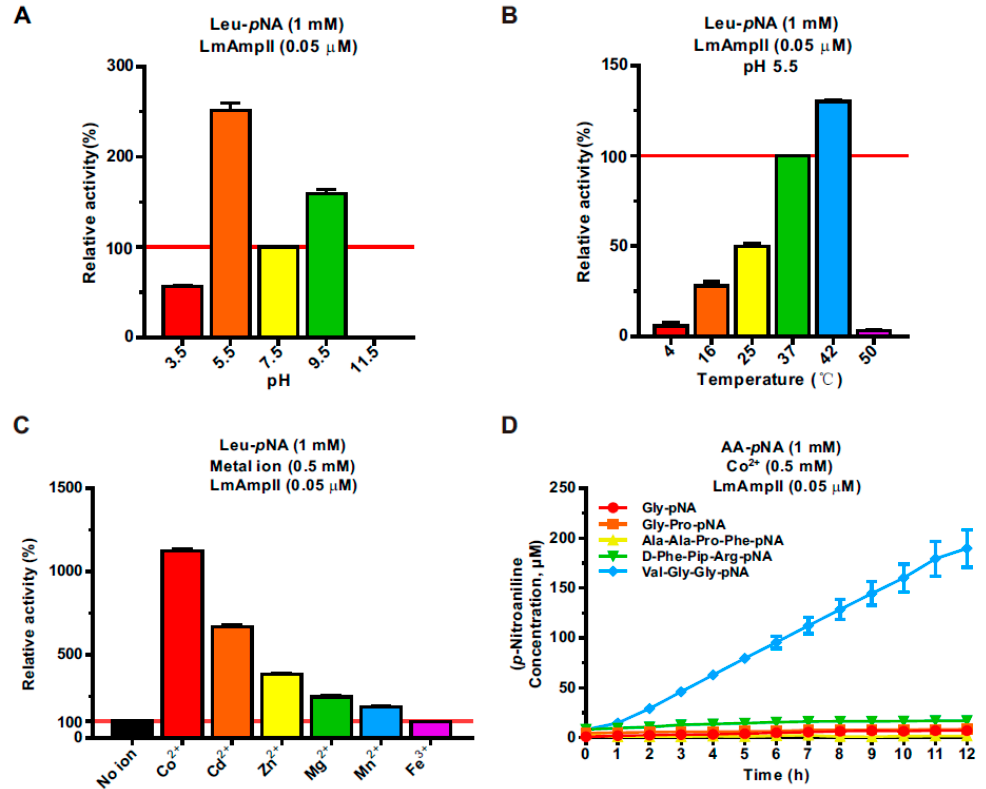
Figure 2. Biochemical characterization of LmAmpII. ( A ) E ff ect of pH on aminopeptidase activity. The enzymatic assays were performed over a pH range from 3.5 to 11.5 in 25 mM Tris-HCl bu ff er using Leu- p -nitroaniline (Leu- p NA) as a substrate. ( B ) E ff ect of temperature on aminopeptidase activity. The enzymatic assays were performed in 25 mM Tris-HCl (pH 7.4) bu ff er over a temperature range from 4–50 ◦ C using Leu- p NA as a substrate. ( C ) E ff ect of metal ions on aminopeptidase activity.